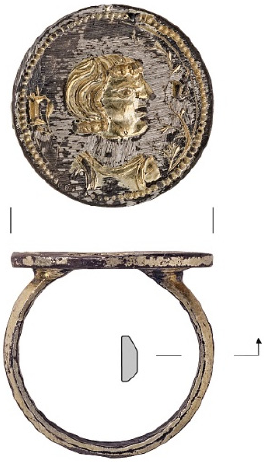
Figure 17. Treasure from Wiener Neustadt. Finger ring with “human head” motif, 1st half 14th century. Photo: Paul Kolp; editing: Franz Siegmeth.